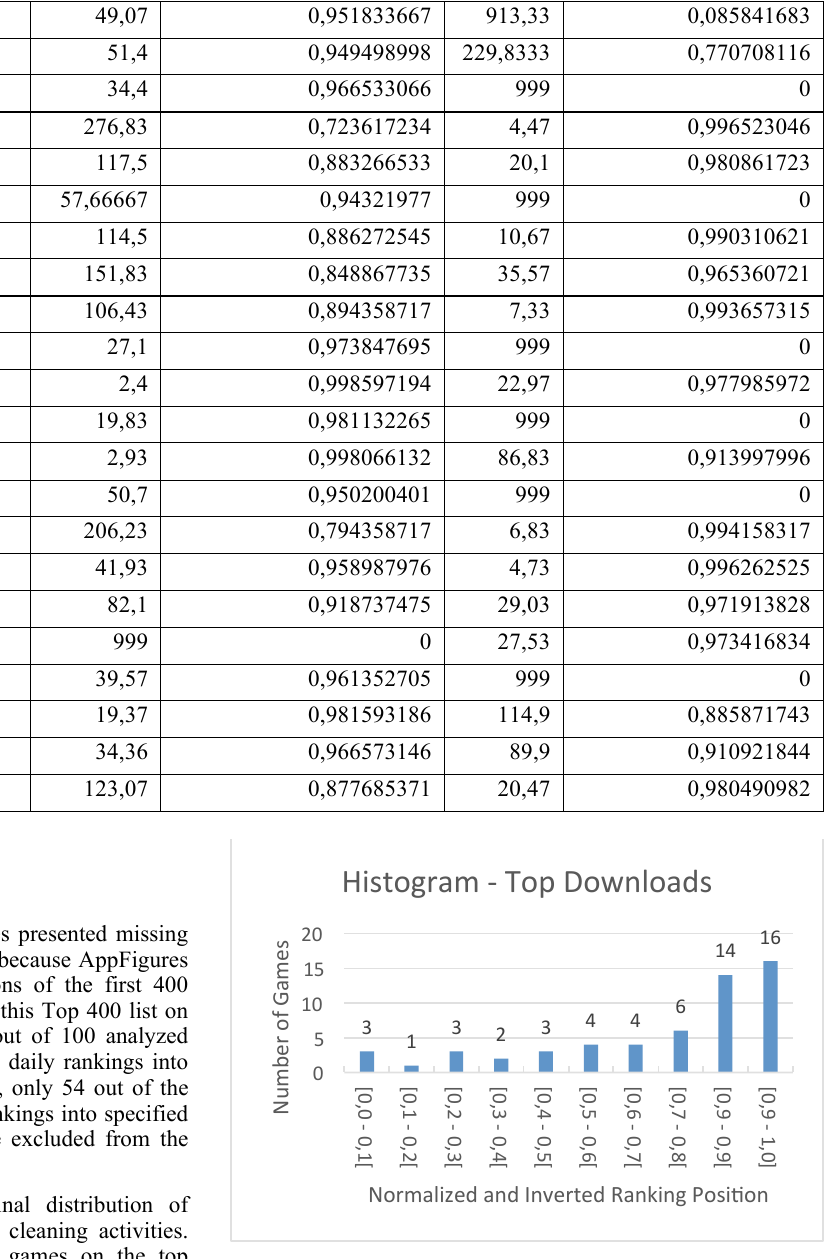
Fig. 2. Histogram of top download games after be normilized and